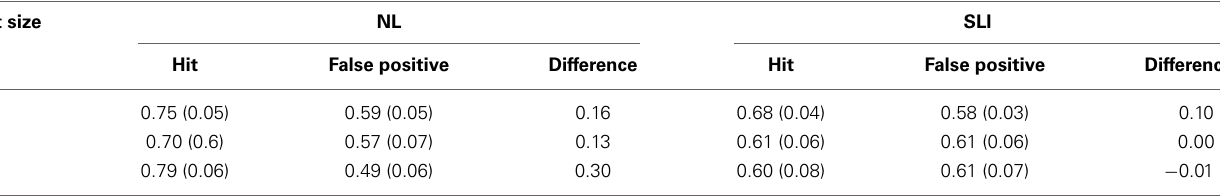
Table 2 | Participants’ responses in terms of hit and false-alarm rates for the NL and the SLI groups. Set size NL